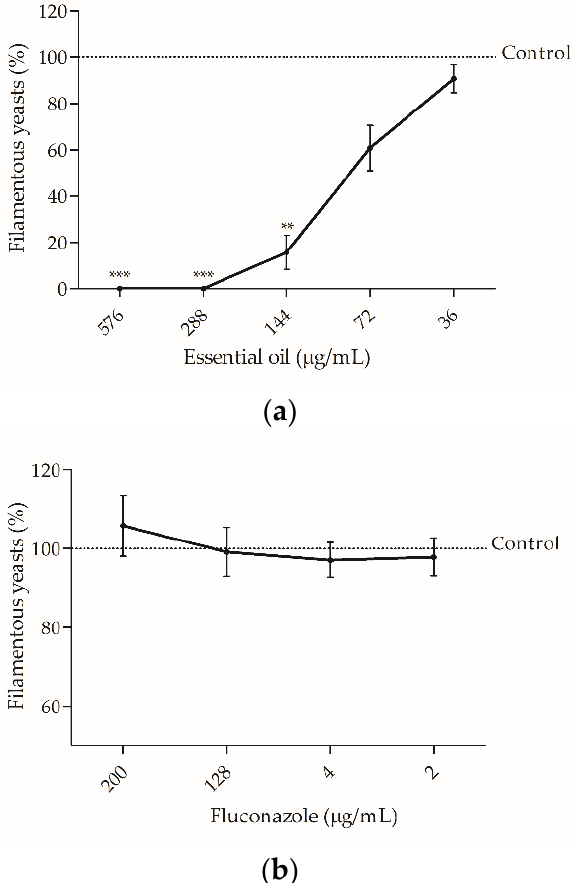
Figure 1. Filamentation percentage of Candida albicans ATCC 10231 treated with different concen- trations of Bupleurum rigidum subp. paniculatum essential oil ( a ) or treated with fluconazole ( b ). One-way ANOVA followed by Dunnett’s Multiple Comparison Test, ** p < 0.01; *** p < 0.001, compared to